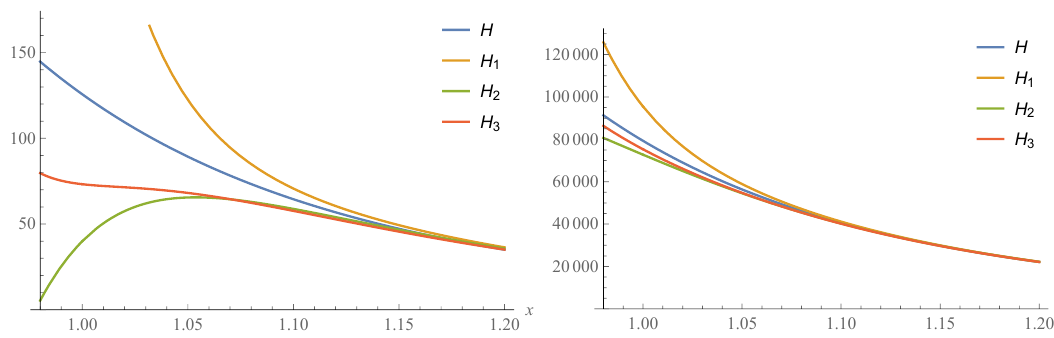
Figure 6 . The behavior of the functions in the metric components. H ( x ) is the classical geometry without the quantum correction, and H 1 ( x ) ; H 2 ( x ) and H 3 ( x ) are with the corrections. Left: the case with N = 456 and ~ T = 0 : 02 : Right: the case with N = 20000 and ~ T = 0 :